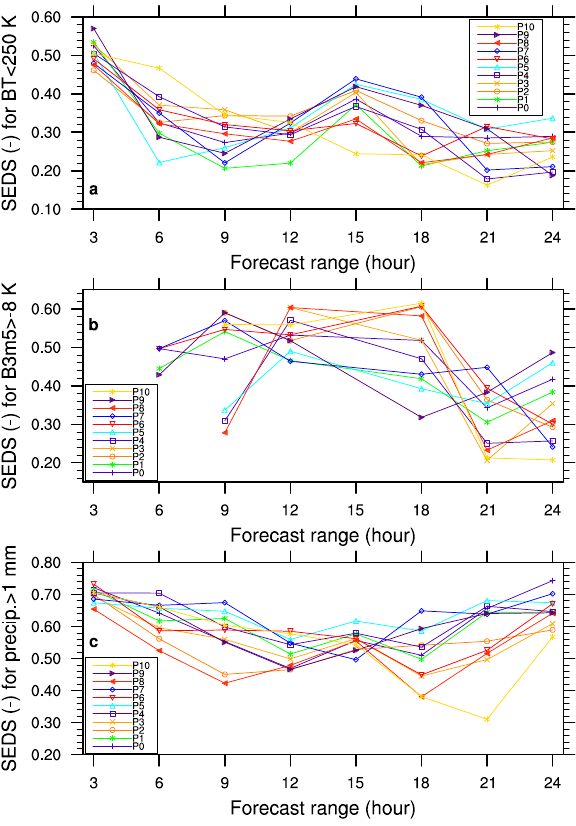
Fig. 10. Time series of SEDS for (a) 10.8 µ m BT less than 250 K, (b) B3m5 larger than − 8 K and (c) 3-h accumulated precipitation greater than 1 mm. SEDSscores were calculated over the domain shown in Fig. 8.